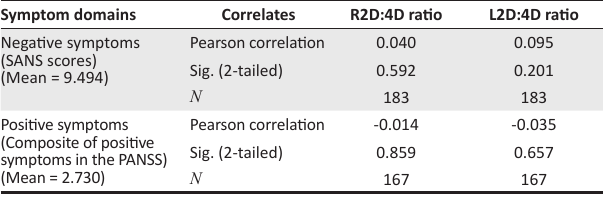
TABLE 2: Positive and negative symptom scores and their digit ratio correlates.